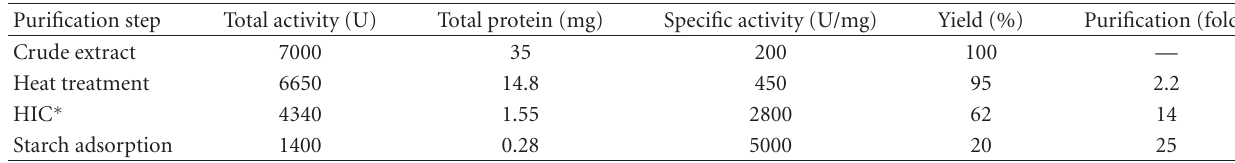
Table 3: Purification steps of the recombinant US132 CGTase.